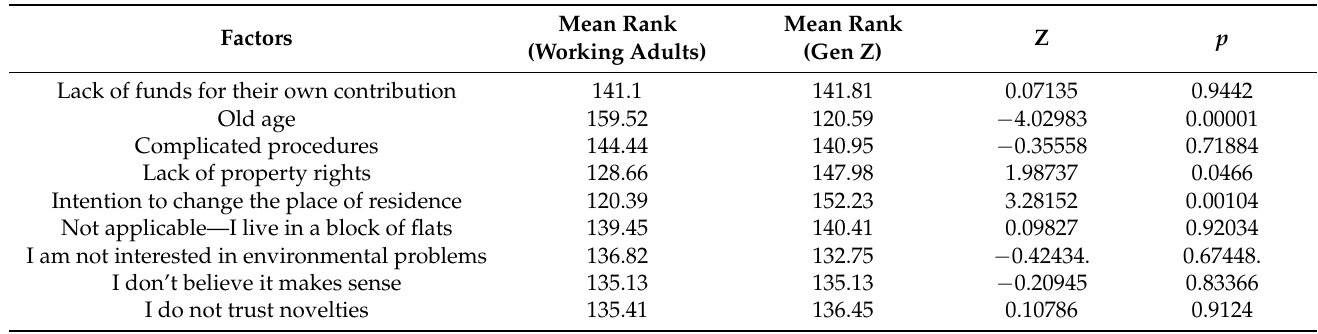
Table 6. The difference in the validity of factors discouraging respondents from participating in pro-environmental programs between “Working Adults” and “Generation Z” (Mann–Whitney